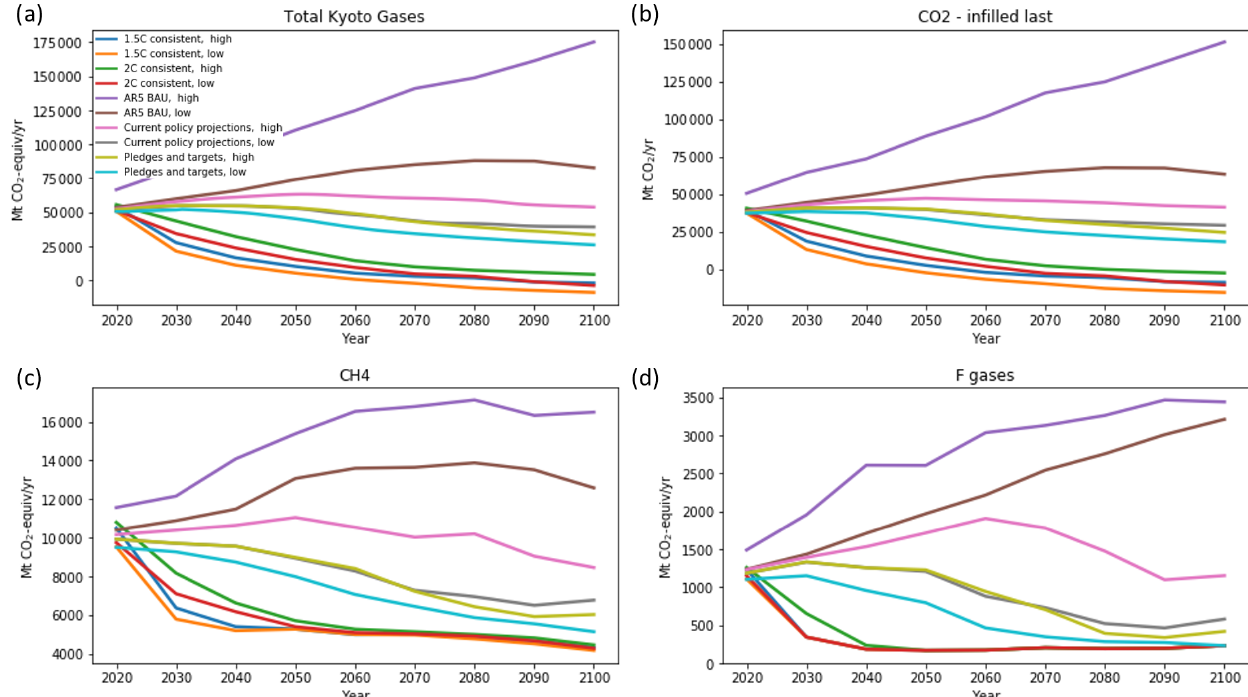
Figure 6. Kyoto gases decomposed by first infilling the non-negative emissions using the (non-ratio) quantile rolling windows, then infilling the CO 2 using infill composite